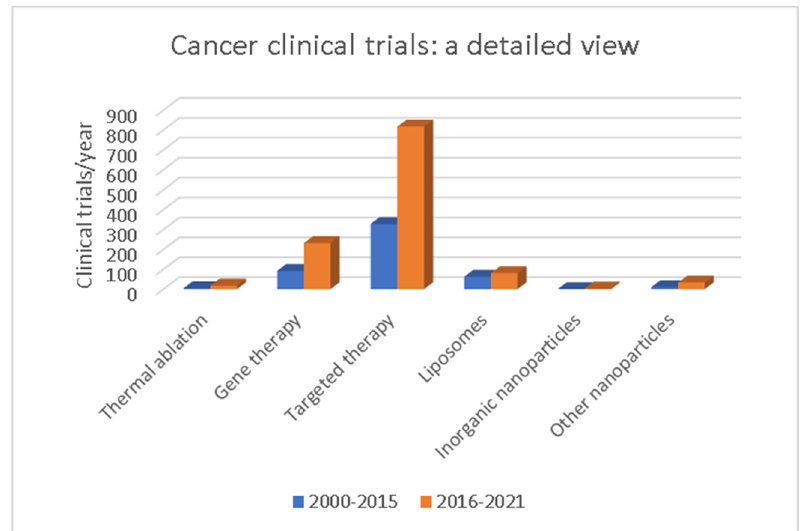
Figure 3. The status of clinical trials using nano–based formulations for cancer therapy. The number of the total and complete clinical trials, currently registered on www.clinicaltrials.gov (accessed on 28 April 2022), undergoing nano-based drugs treatment alone or in combination with other therapeutics during the periods 1995–2015 and 2015–2021. The results are expressed as the number of clinical trials divided by the number of years per period. In the last 10 years, second-generation DDS using active targeting have been the most widely tested systems in clinical trials.